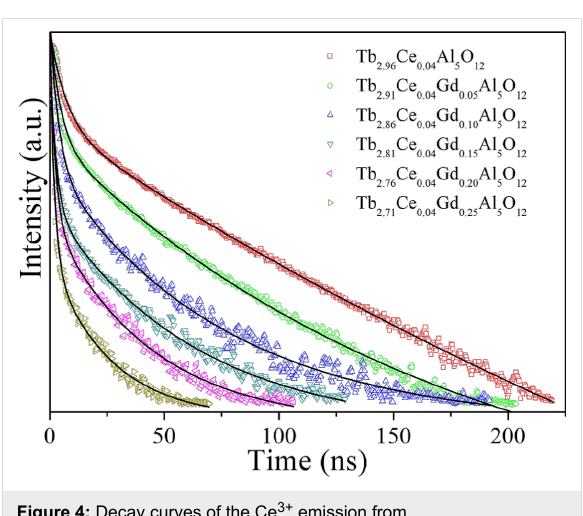
Figure 4: Decay curves of the Ce 3+ emission from Tb 2.96 − x Ce 0.04 Gd x Al 5 O 12